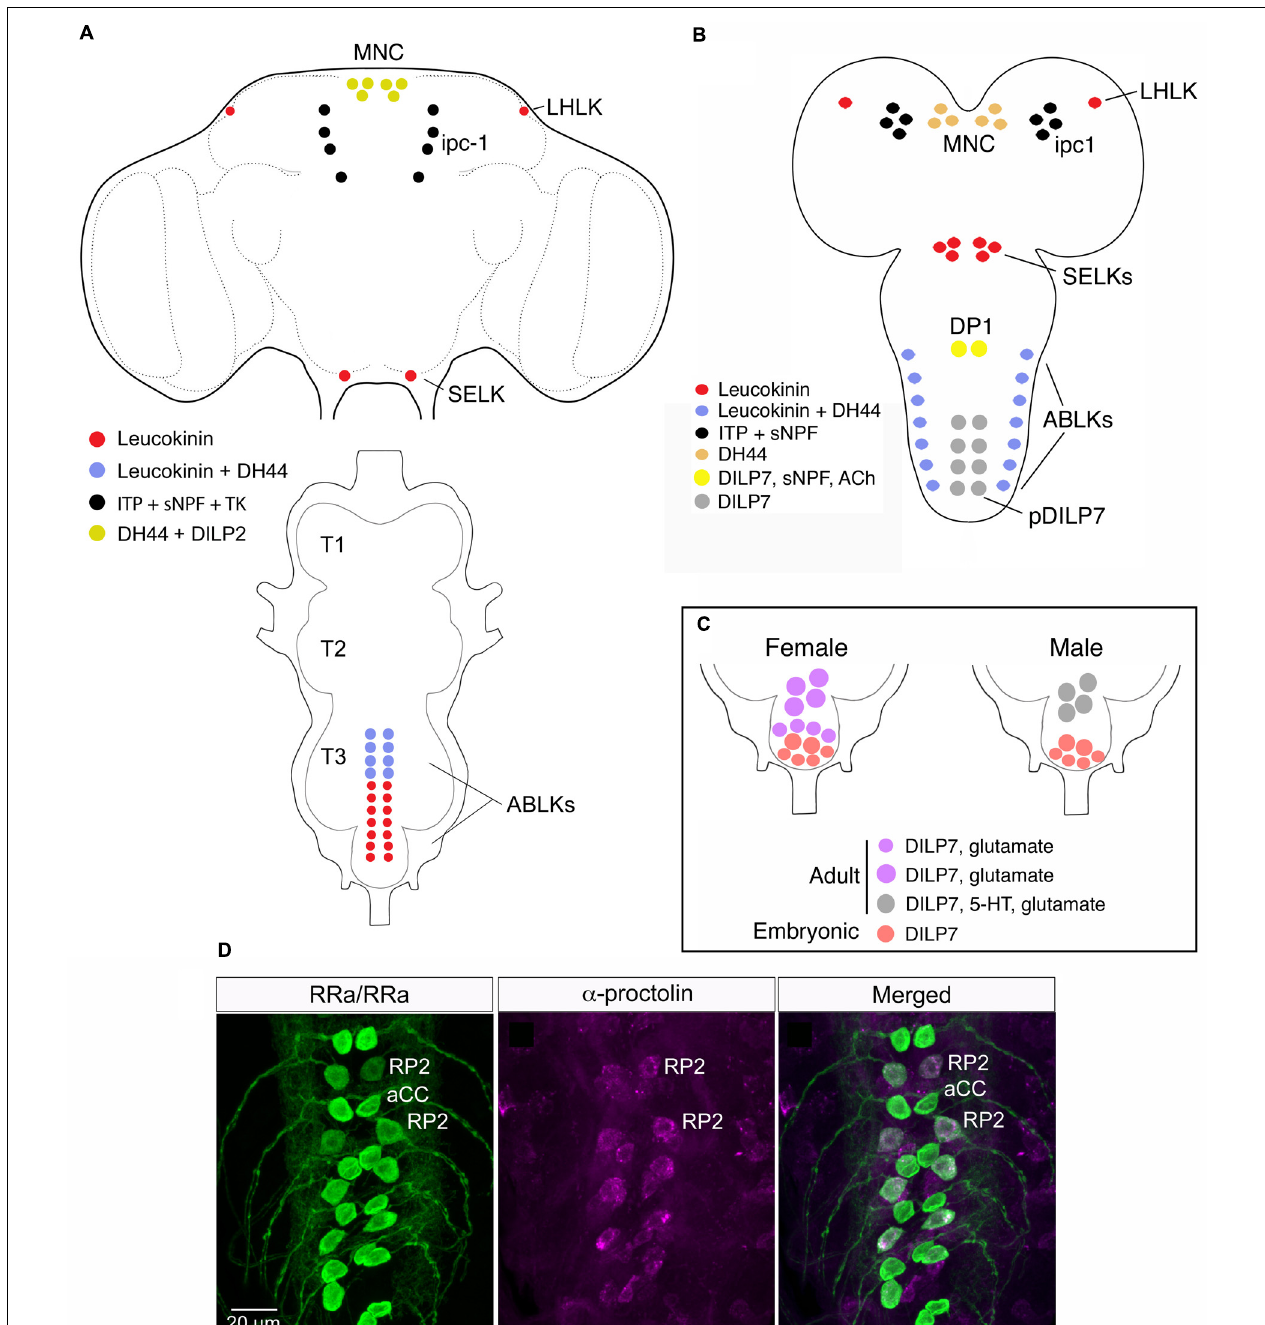
FIGURE 3 | Neuroendocrine cells colocalizing neuropeptides and neurotransmitters in the CNS of adult and larval Drosophila . (A) Neuroendocrine cells colocalizing leucokinin and diuretic hormone 44 in the adult CNS. In the brain there are 4 neurons expressing leucokinin (LK), 6 neurons producing diuretic hormone 44 (DH44) and 8 ipc-1 neurons producing ion transport peptide (ITP; shown because they express Lk-Gal4), tachykinin (TK) and sNPF. In the abdominal ganglion at least 8 of the 22 ABLKs coexpress LK and DH44. Note that in adults, but not larvae the brain MNCs coexpress DH44 and DILP2 (Ohhara et al., 2018). This figure is slightly altered from Zandawala et al. (2018). (B) In third instar larvae all ABLKs coexpress LK and DH44. In younger larvae the ipc-1 neurons, in addition to ITP and sNPF, express weak LK (de Haro et al., 2010; Kahsai et al., 2010). One subset of midline neurons expressing DILP7, the DP1 neurons, coexpress sNPF and acetylcholine (Ach) (Nässel et al., 2008). (C) In adult flies the posterior DILP7 expressing neurons in abdominal ganglia consist of neurons derived from the embryo (pDILP7 in B ) and adult-specific ones that are generated later. There is a sex-dimorphism in that females have a larger number of adult DILP7 neurons that also produce glutamate, whereas in males the adult DILP7 neurons produce additional serotonin (5-HT) (Castellanos et al., 2013). (D) In each neuromere of the larval ventral nerve cord (VNC) there is a pair of midline motor neurons, aCC and RP2 that signal with glutamate. The RP2 neurons also produce proctolin from Luo et al. (2017).